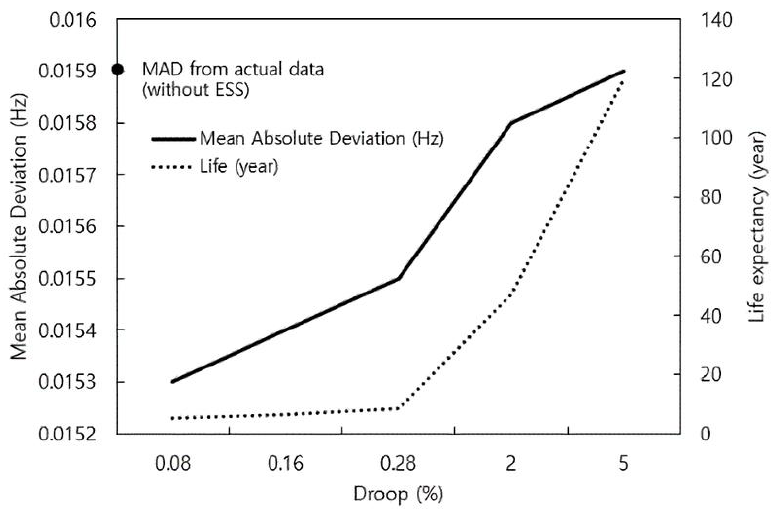
Figure 11. Performance and life evaluation according to droop change.